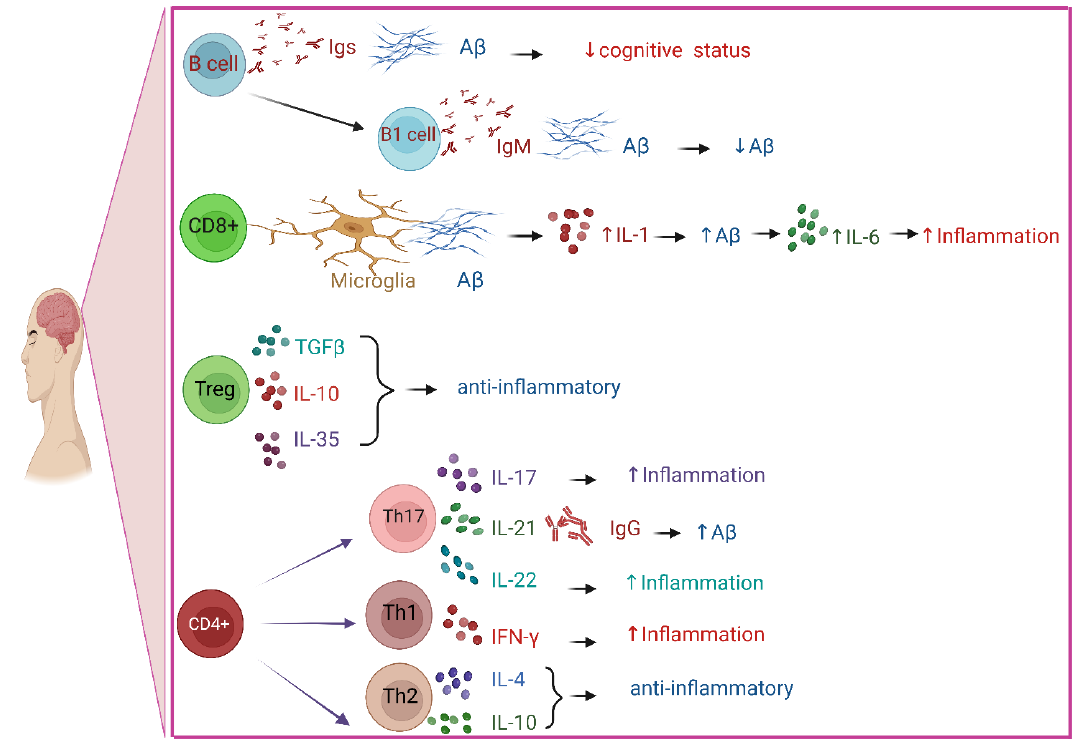
Figure 2. CD4 + T cells differentiate and proliferate into Th1, Th2, and Th17 cells. Th17 and Th1 cells secrete proinflammatory cytokines, but Th2 secrete ant-inflammatory cytokines. Depletion of Tregs worsens mice’s cognitive impairment. Immunosuppressive anti-inflammatory cytokines are released by Tregs. While it is thought that immunoglobulin encourages and accelerates the uptake of Aβ plaques by microglia, it is also thought that the Aβ–IgG complex in the CSF has a negative impact on the cognitive health of AD patients. Created with BioRender (BioRender.com).